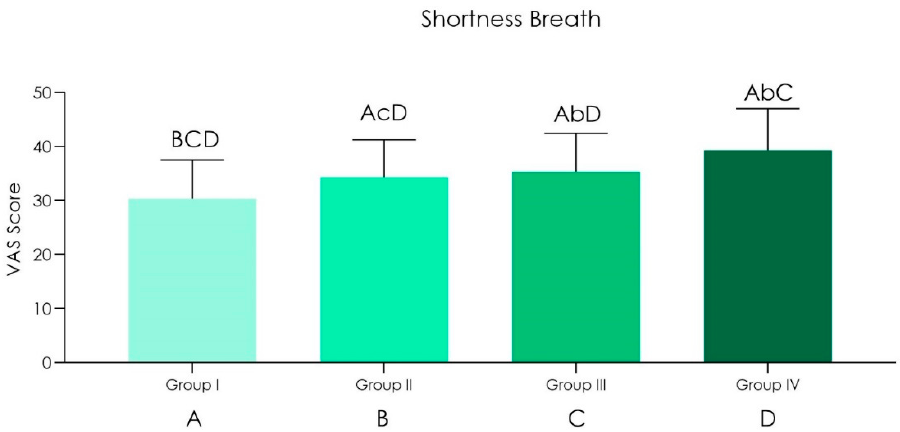
Figure 3. Graph chart of the shortness breath visual analogic score (VAS) score perception of Group I (20 min), II (20–40 min), III (40–120 min) and IV (120–240 min) (ANOVA post hoc Tukey HSD) (Top Bars between groups comparison: lower case p < 0.05; upper case: p > 0.05).